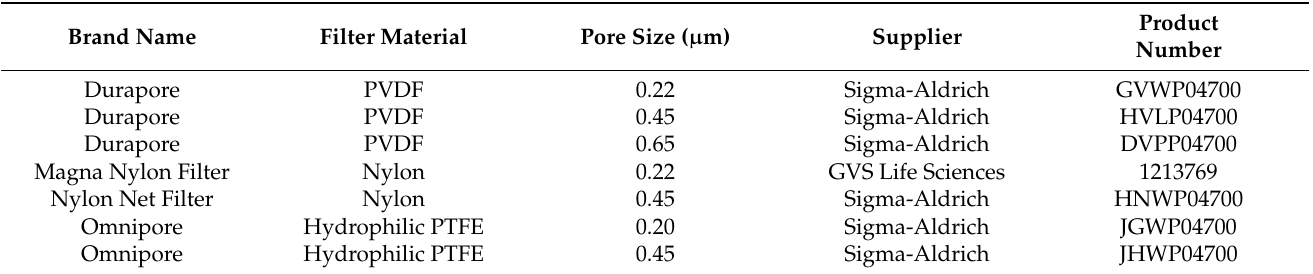
Table 1. Brand name, filter material, pore size ( µ m), supplier, and product number of 47 mm membrane disc filters tested for fast filtration-based sampling of E. coli for metabolite profiling. PVDF, polyvinylidene difluoride; PTFE,